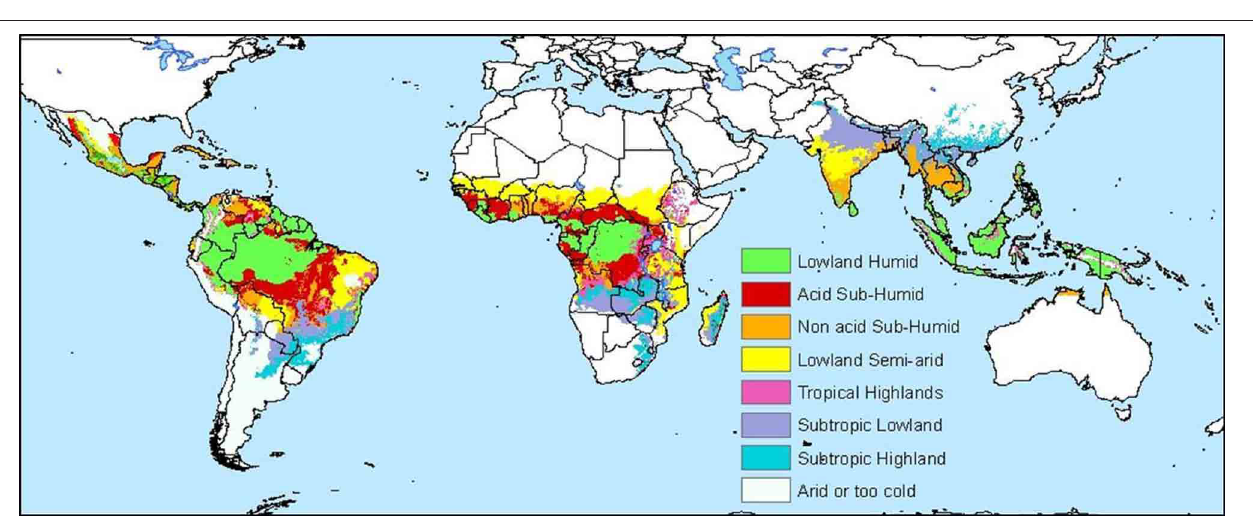
FIGURE 3 | The Homologue model showing areas similar in climate to Bambey, Senegal.